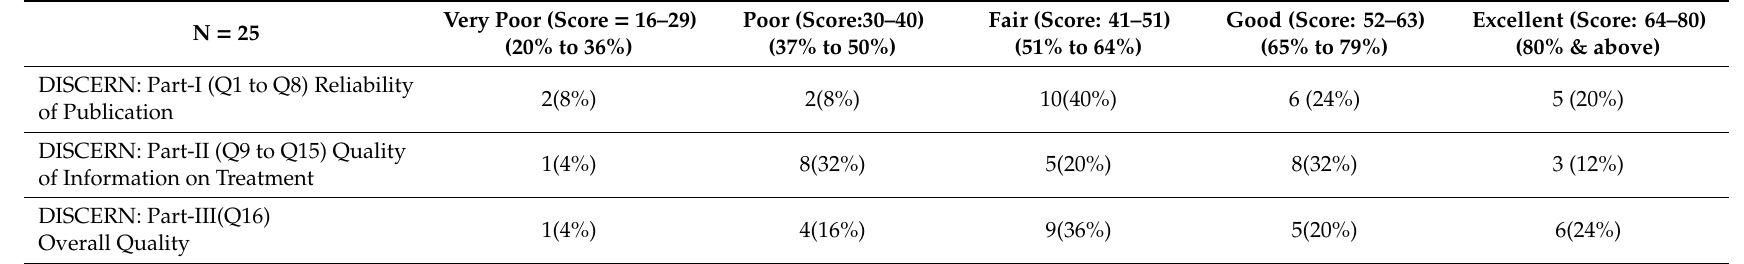
Table 5. Evaluation of all included websites by Group 2 (Lay Subjects